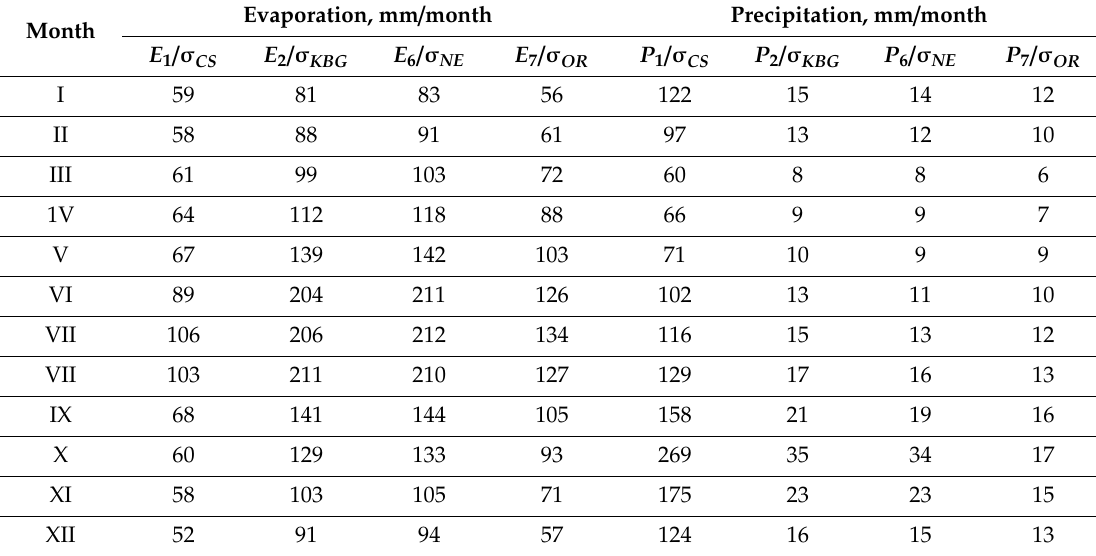
Table 2. Principal elements of the Aral Sea water balance. Notation: σ CS = 371,000 km 2 , σ KBG = 18,000 km 2 , σ OR = 21,400 km 2 , σ NE = 70,000 km 2